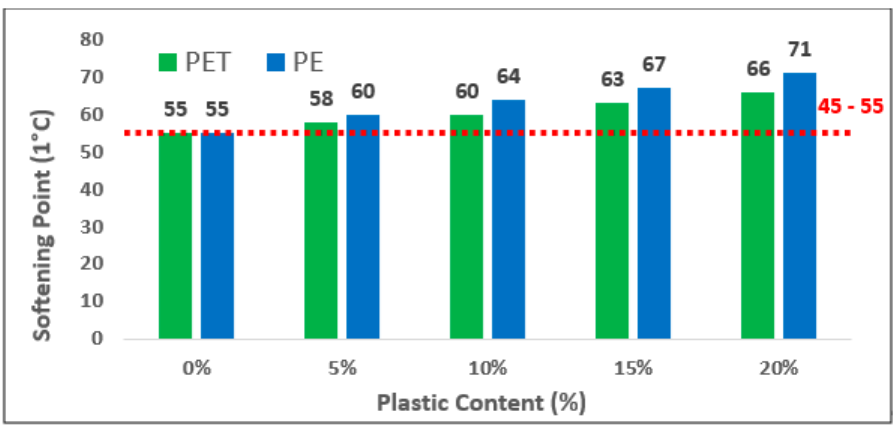
Figure 7. Softening Point of Modified Bitumen versus different Plastic contents.